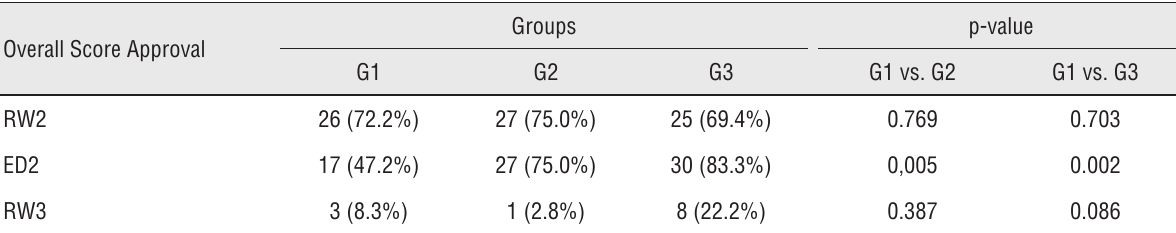
Table 3 - Impact of the